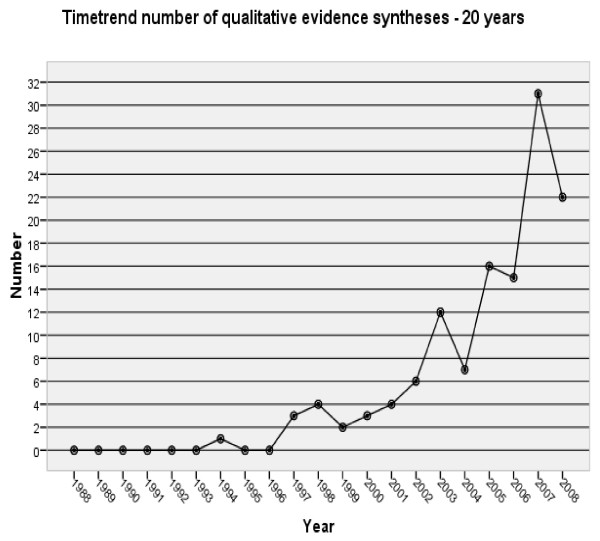
Adapted from Hannes and Macaitis [[20]].